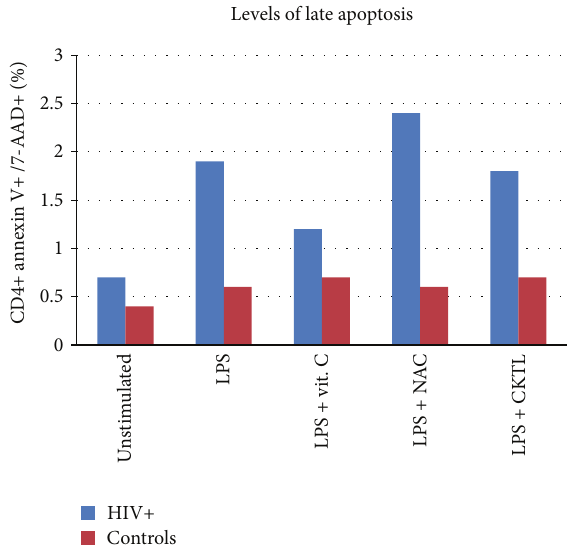
Figure 4: The figure shows the median % annexin V+/7-AAD+ staining on CD4+ T-cells under different experimental conditions for both HIV positive and control groups. LPS did not induce a significant increase in annexin V+/7-AAD+ staining in both groups ( 𝑃 > 0.05